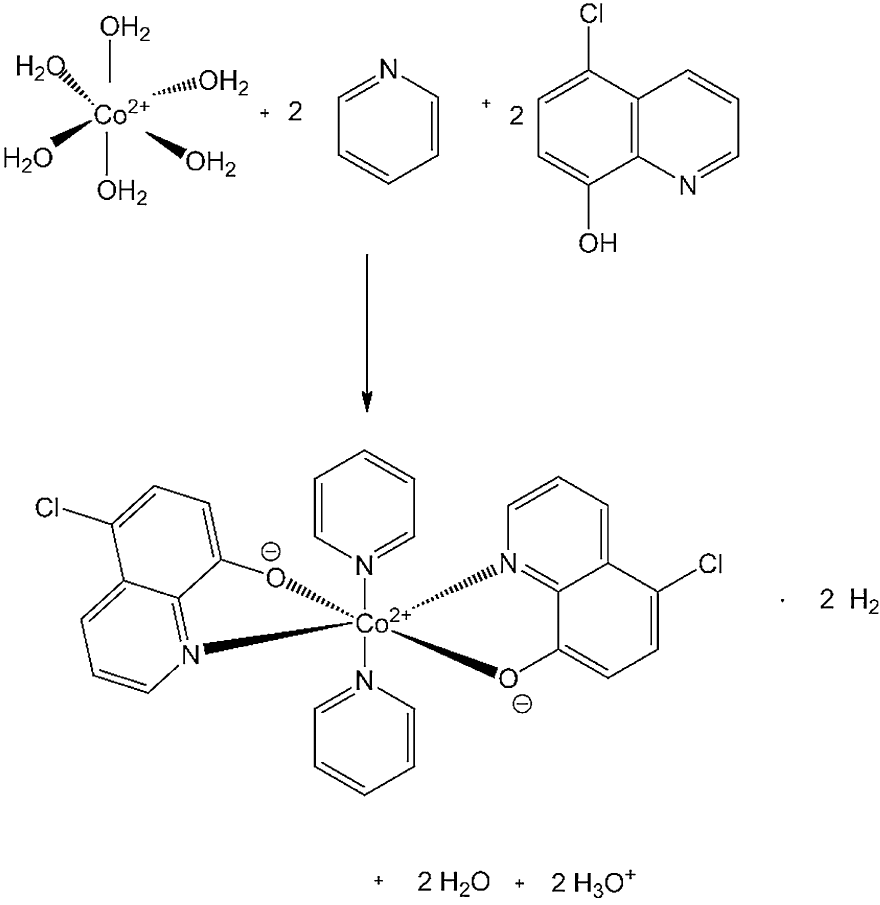
Figure 5. The diagram of formation of the bis(5-chloroquinolin-8-olato)-bis(pyridine)-cobalt(II)